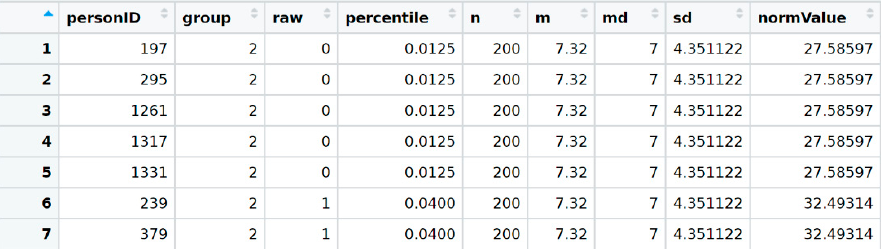
Figure 3. Result of the inverse normal transformation of the manifest data, including manifest percentiles and norm scores ( T -scores) as well as group-specific descriptive data. The column ‘normValue’ will serve as the location l in the following.